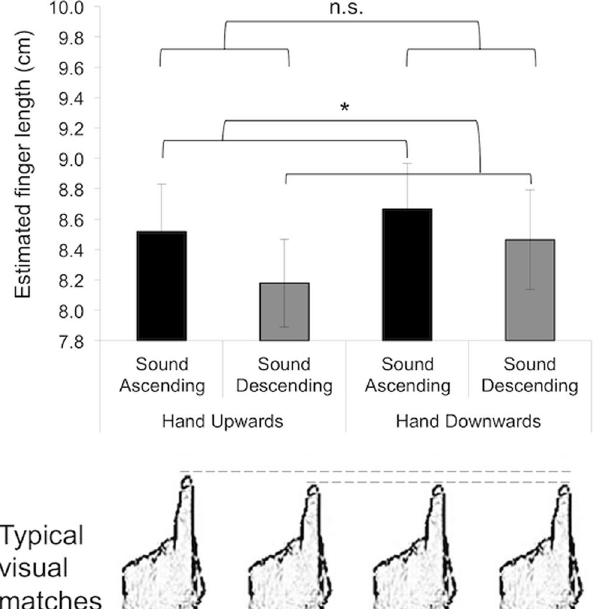
Figure 3. Results of Experiment 2: Mean ( ± s.e.m.) estimated finger lengths as a function of condition in Experiment 2 (N = 24). The asterisk indicates significant differences between sound conditions ( p < 0.05, corrected for multiple comparisons).n.s. refers to non-significant differences between sound conditions. Longer finger length estimates were found for the ‘ascending’ sound, as compared with the ‘descending’ sound. No effects of pointed direction were found. The bottom panel displays finger drawings chosen by participants to describe the subjective feeling of their finger when listening to the sound (the drawing closest to the mean choice is displayed as a function of condition). Participants selected significantly larger visual matches to their index finger after the ‘ascending’ as compared to the ‘descending’ conditions and after the ‘upwards’ as compared